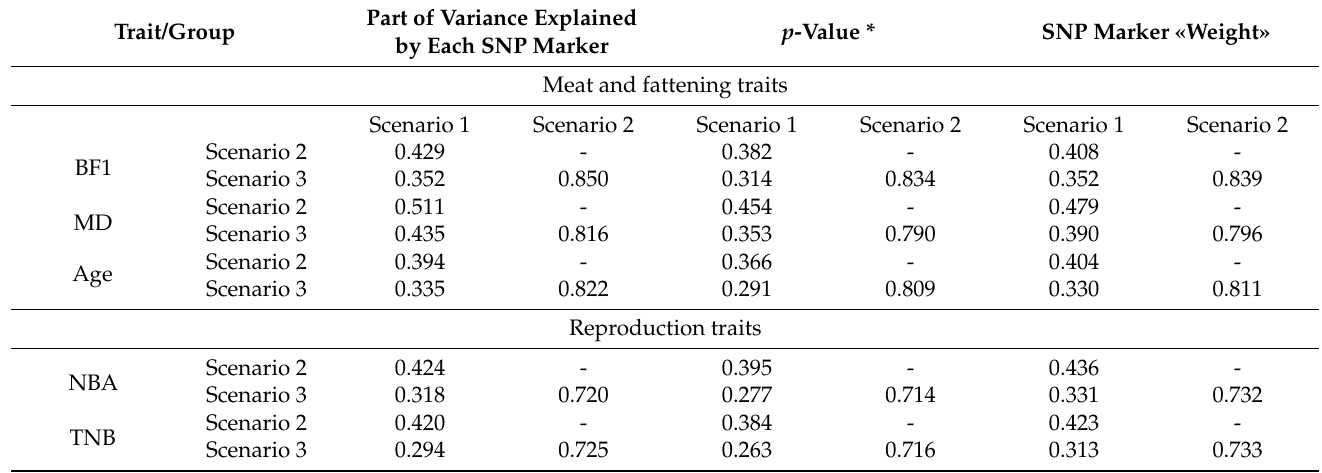
Table 7. Correlation of parameters of compared reference